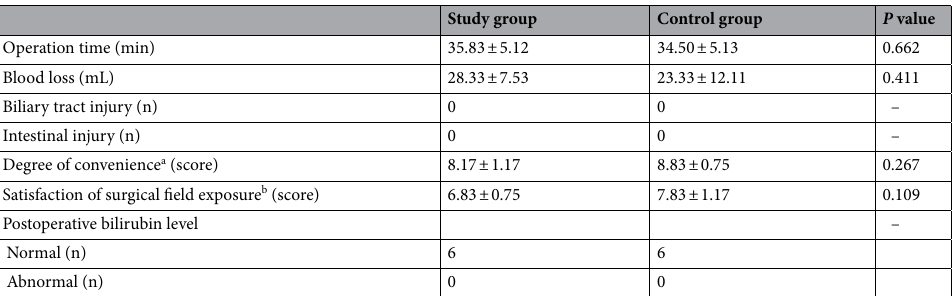
Table 1. Comparison between the study group and the control group. a The degree of convenience was